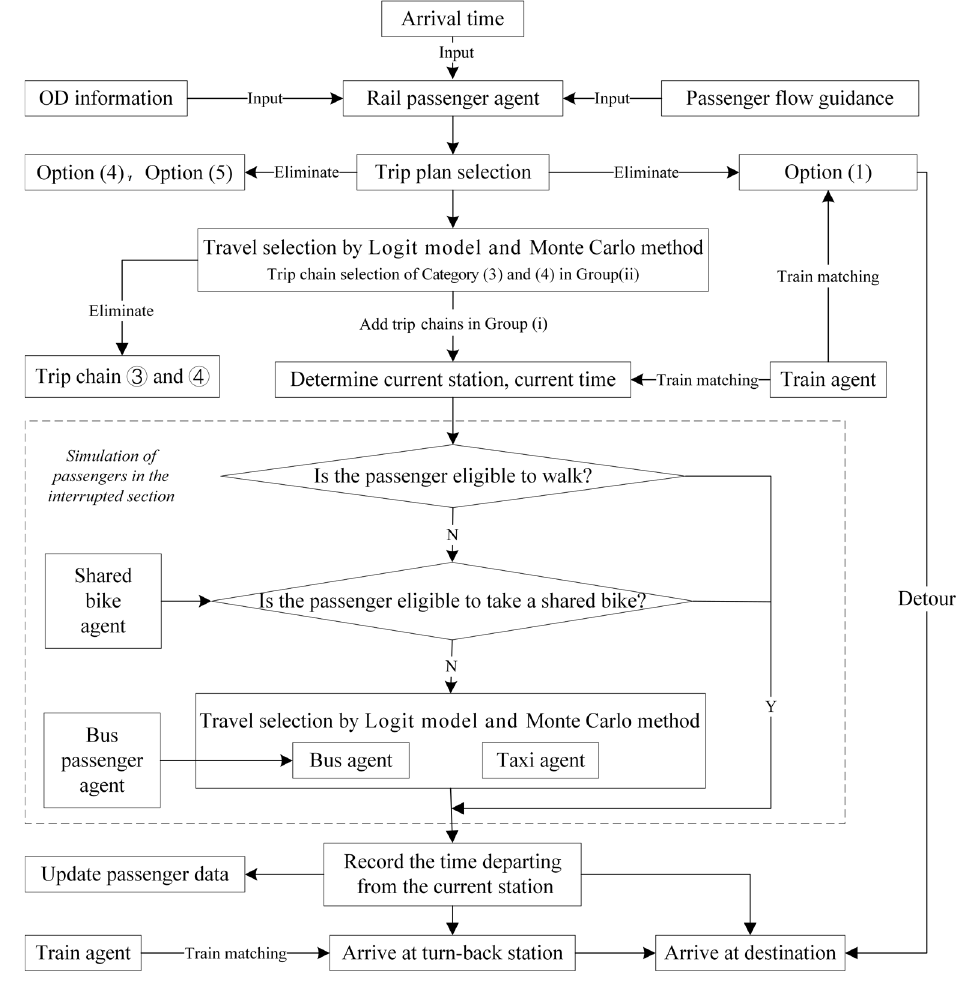
Figure 5. Rail passenger agent main function.